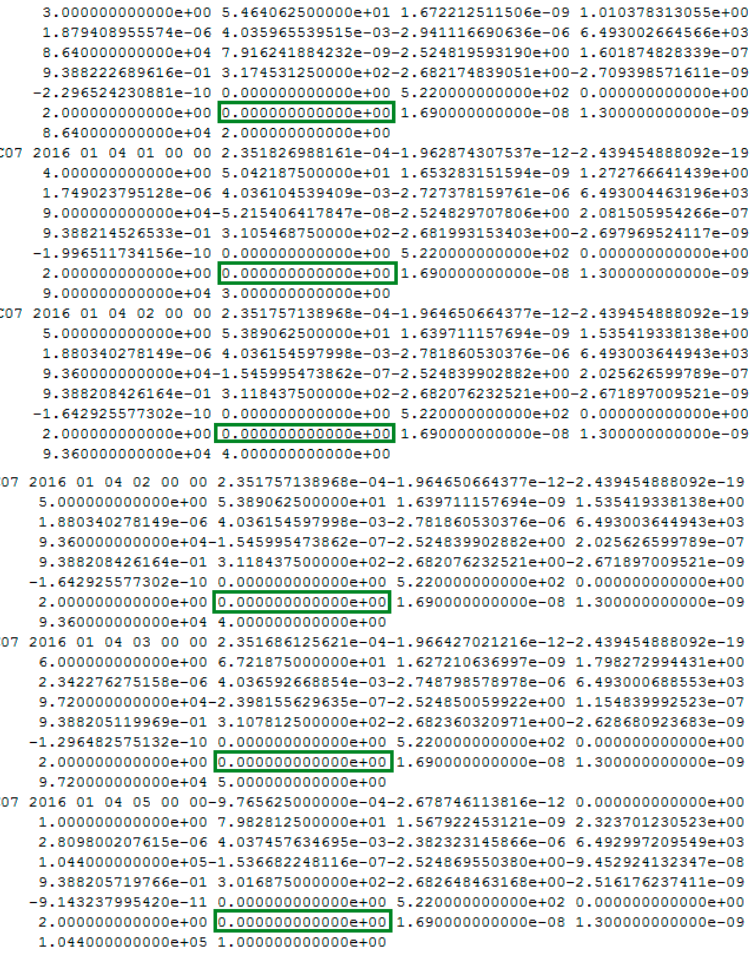
Figure 14. The health marks of C07 in the broadcast ephemeris. The green box highlights the health status marked 0 at the corresponding time of the abnormal status.